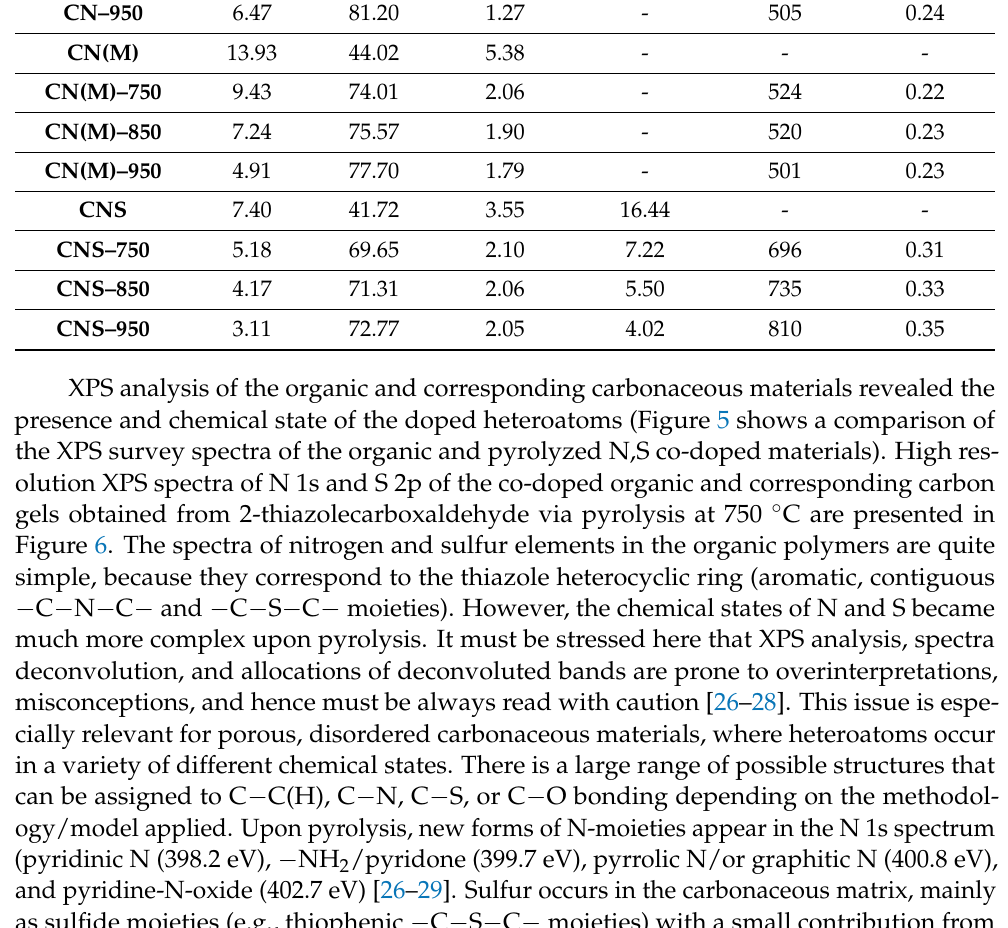
Table 1. Elemental analysis and textural characteristics of the organic and carbon gels obtained from a phloroglucinol:aldehyde molar ratio of 1:3. Sample